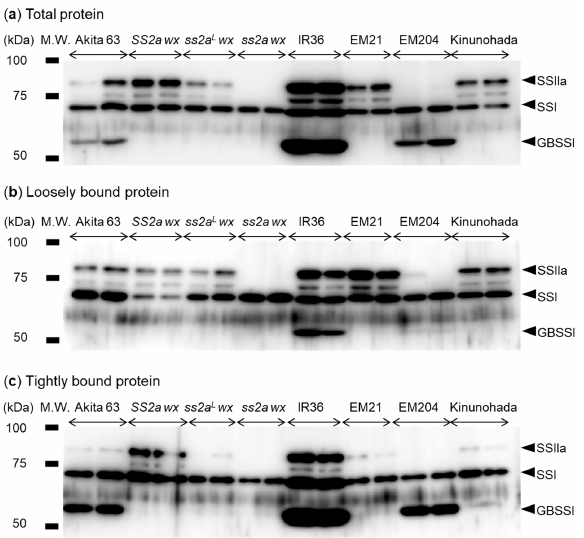
Figure 2. Analysis of SSI, SSIIa, and granule-bound starch synthase (GBSS) I protein abundance in mature seeds. ( a ) Analysis of total protein extracted from mature seeds by Western blotting using anti- SSI, -SSIIa, and -GBSSI antibodies. SSI served as a loading control. ( b , c ) Western blotting analysis of proteins loosely bound ( b ) and tightly bound ( c ) to starch granules. Two samples each were prepared from individual grains of the same genotype.